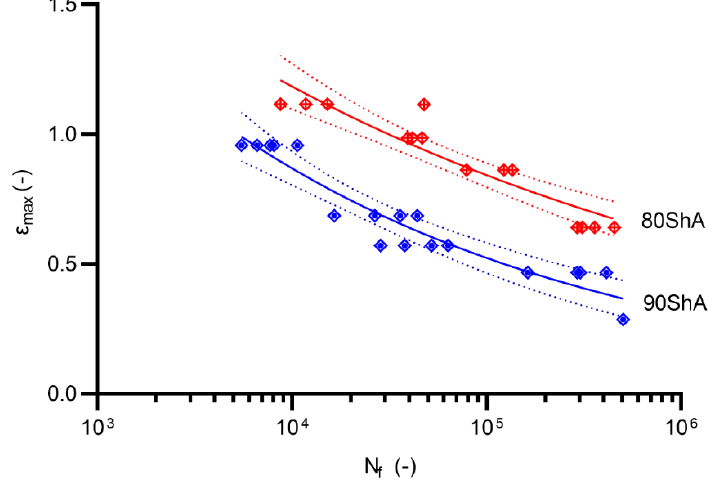
Figure 17. Fatigue data for R = 0 represented by ε max -N approach (80 ShA and 90 ShA).